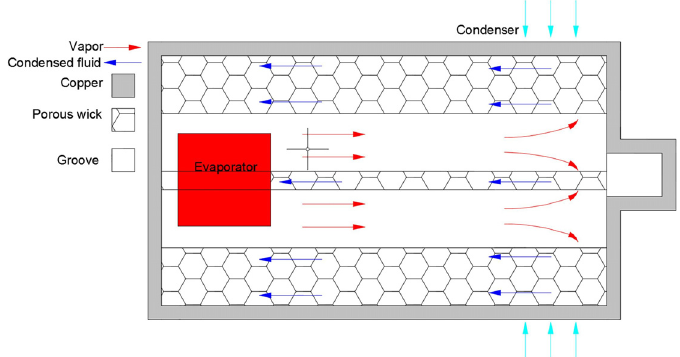
Figure 16. Vapor–liquid entrainment phenomenon [81].